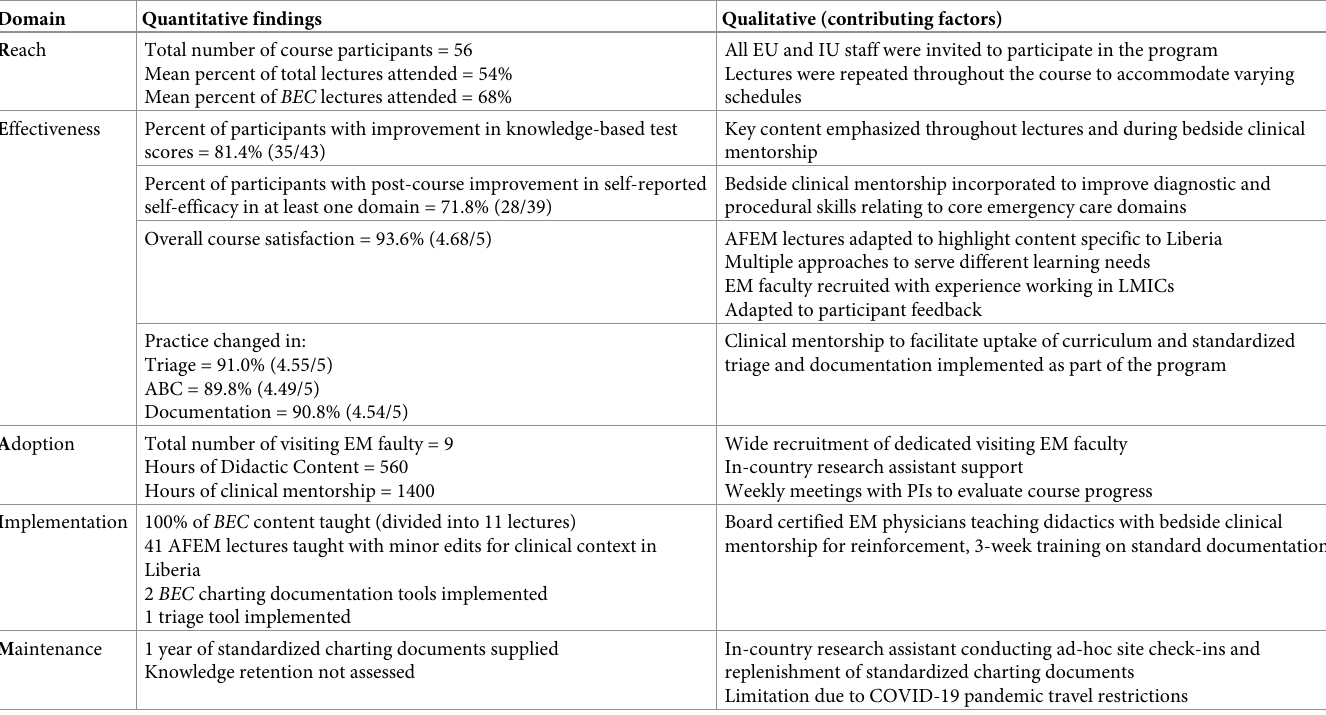
Table 5. Evaluation of comprehensive emergency care program using the IS RE-AIM framework. Domain Quantitative findings Qualitative (contributing